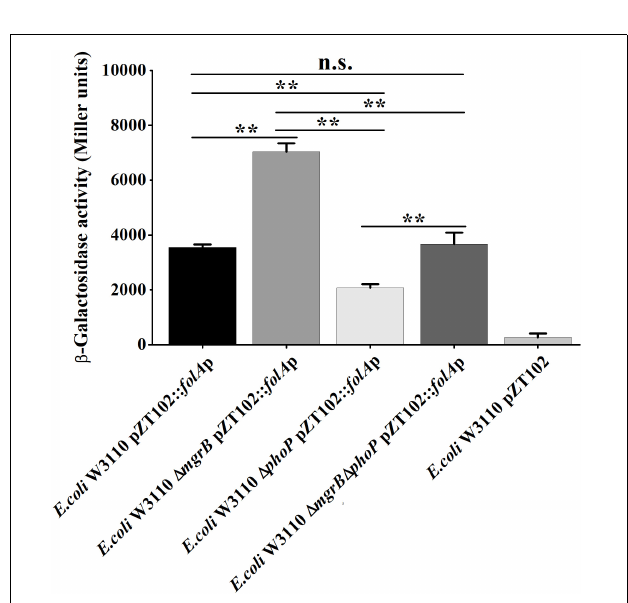
FIGURE 3 | A comparison of promoter activity of folA in various strains of E. coli using lacZ -fusion analysis. β -Galactosidase activities were measured from exponential phase aerobic cultures in LB of several E. coli W3110 strains: wild-type (WT), null mutants ( (cid:49) phoP and (cid:49) mgrB ), and a double mutant ( (cid:49) mgrB (cid:49) phoP ), all of them carrying a reporter plasmid pZT102: folA p-257 containing the promoter region of folA (–231/+26). CK is empty pZT102 plasmid control in E. coli W3110. Means and standard deviations are represented. Data represent mean ± SD from three independent experiments. P values were calculated using t tests (* P < 0.05; ** P < 0.01; *** P <